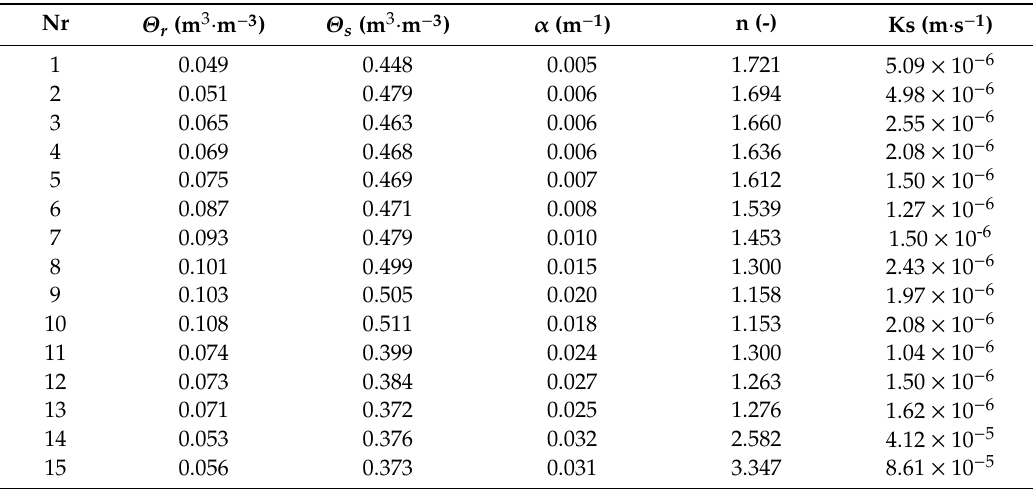
Table 1. Representative van Genuchten parameters of the 15 classes of the classification based on hydraulic response with dynamic boundary